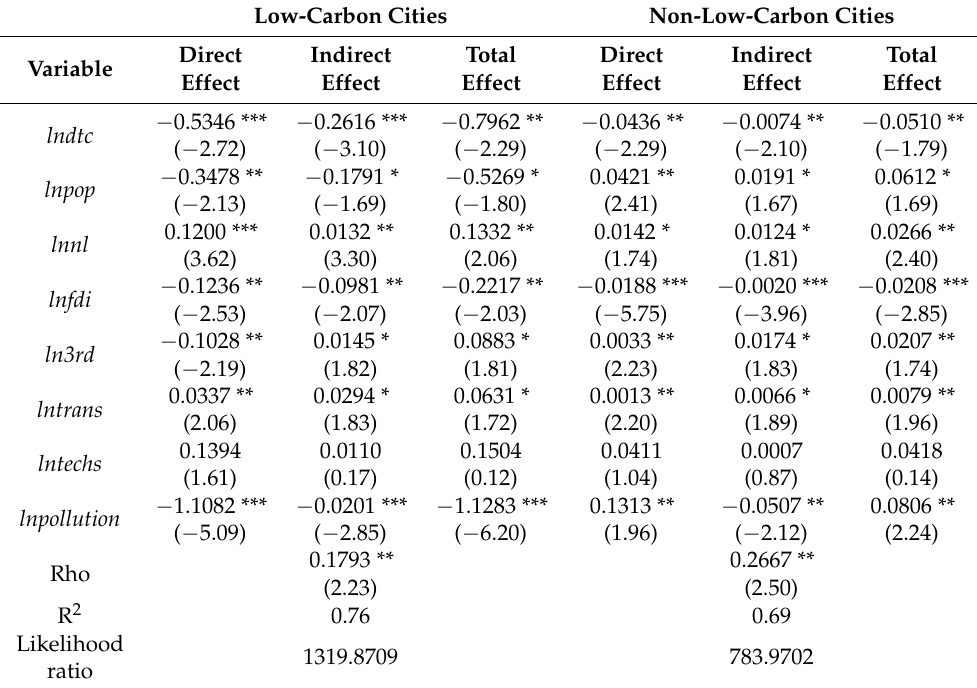
Table 7. Low-carbon cities and non-low-carbon